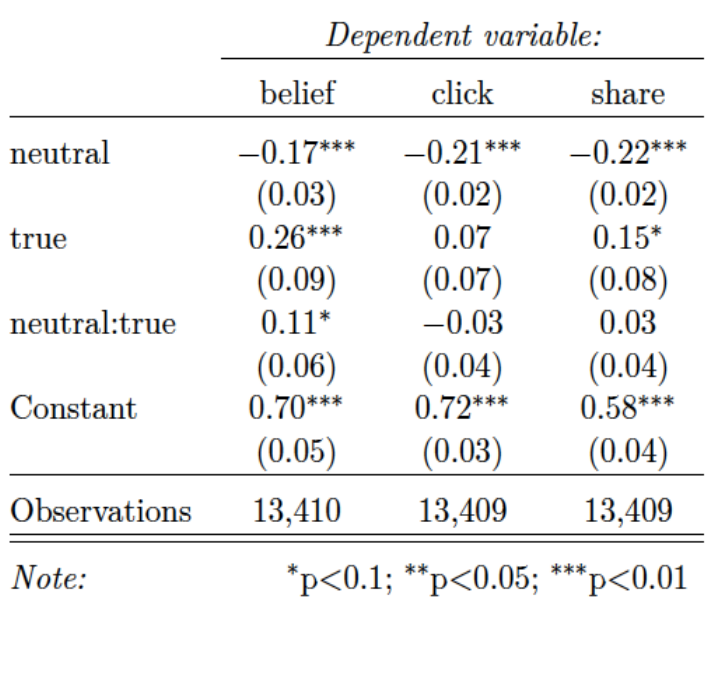
Table B1. Association between neutral (no emotion) and belief, click, and